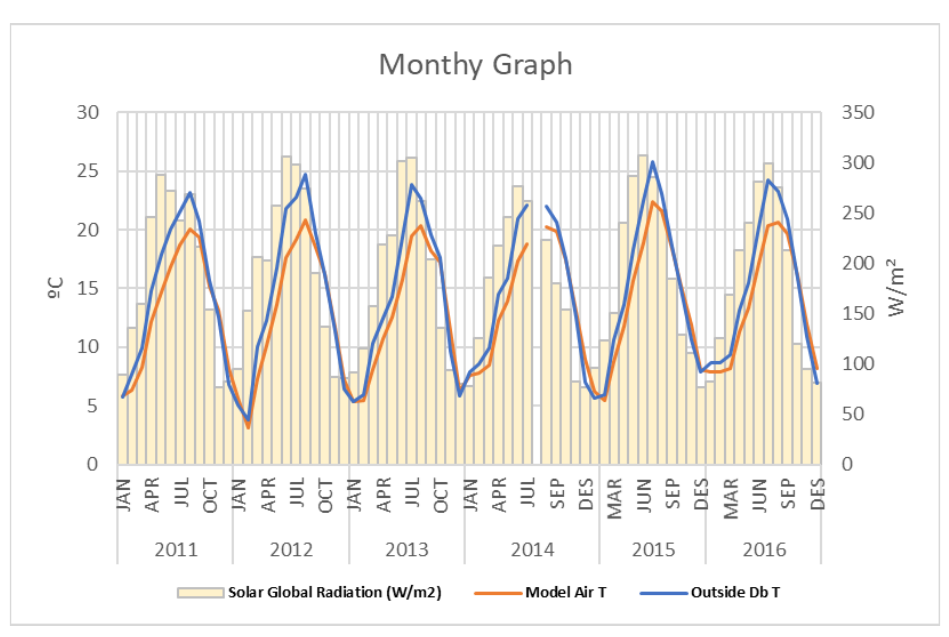
Figure 18. Comparison of outside and EnergyPlus model air temperatures.